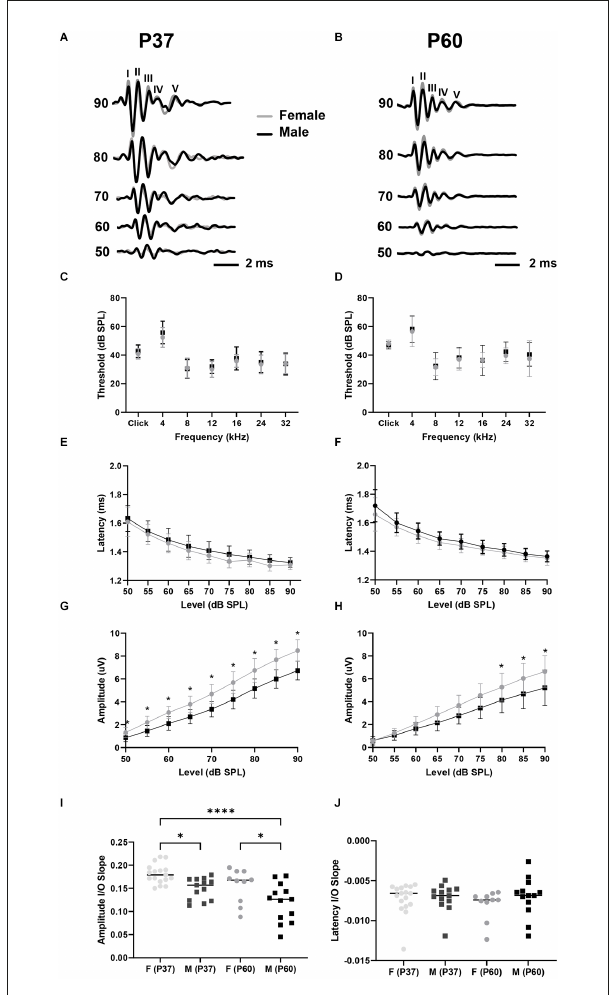
FIGURE2 Female mice have larger wave I amplitudes than males. (A,B) Representative ABR waveforms evoked with clicks from P37 female (gray line, n = 17) and male (black line, n = 13) mice (A) and P60 female ( n = 10) and male ( n = 13) mice (B) . Waves—V are labeled. (C,D) ABR analysis showed no sex differences in click and pure tones thresholds for P37 (C) or P60 (D) mice. (E,F) There was no sex difference in ABR click wave I latency for P37 (E) or P60 (F) mice. (G,H) Female mice aged P37 have larger click wave I amplitude than male mice at sound intensities equal to and above 50 dB SPL (G) , and female mice aged P60 have larger click ABR wave I amplitude at sound intensities equal to and above 80 dB SPL (H) . (I) Linear slopes of click wave I amplitude as a function of sound level are larger for females aged P37 compared to males aged P37 and P60, and slopes are higher for females aged P60 compared to males aged P60. (J) Linear slopes of click wave I latencies do not differ between sexes at any age. Error bars represent ± SD. Lines on (I,J) scatterplots denote the median. * p < 0.05, **** p <